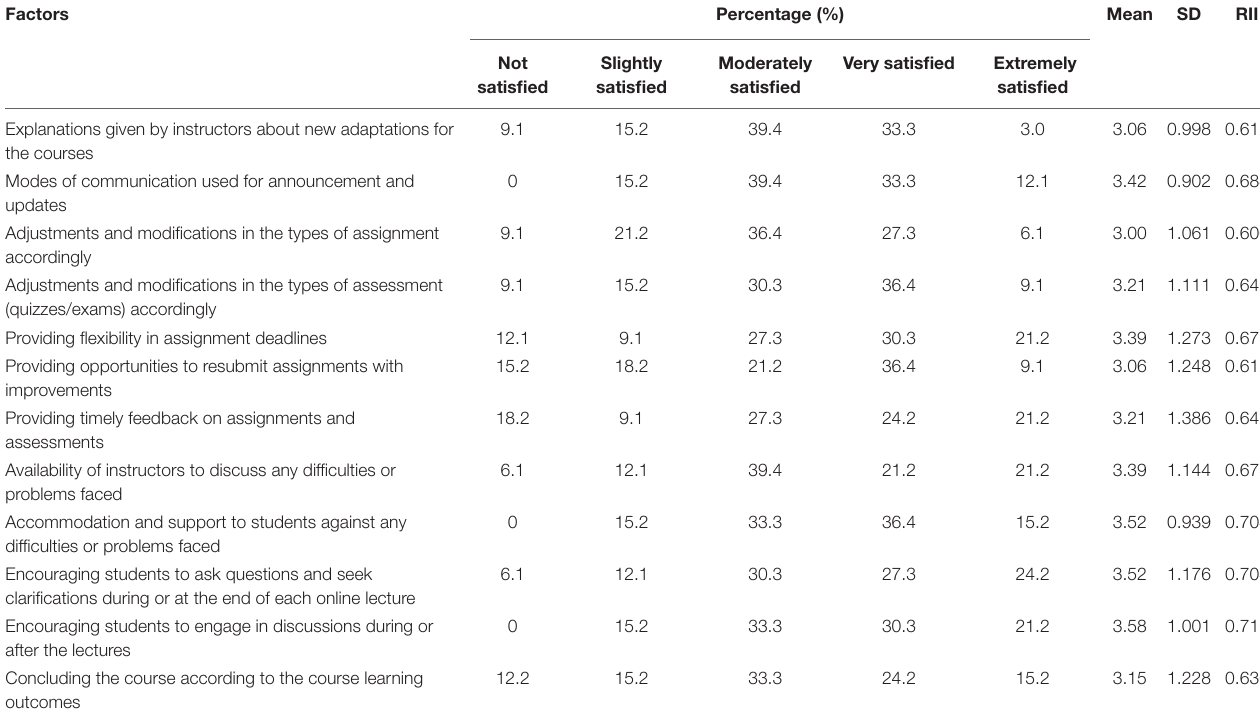
TABLE 4 | Students’ opinions about instructors’ performance on online